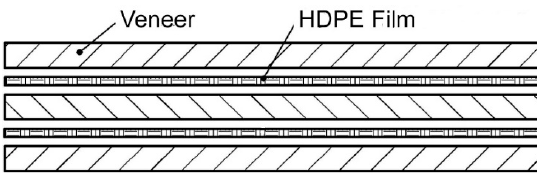
Figure 1. Structure of three-layer high-density polyethylene HDPE-bonded plywood panels.